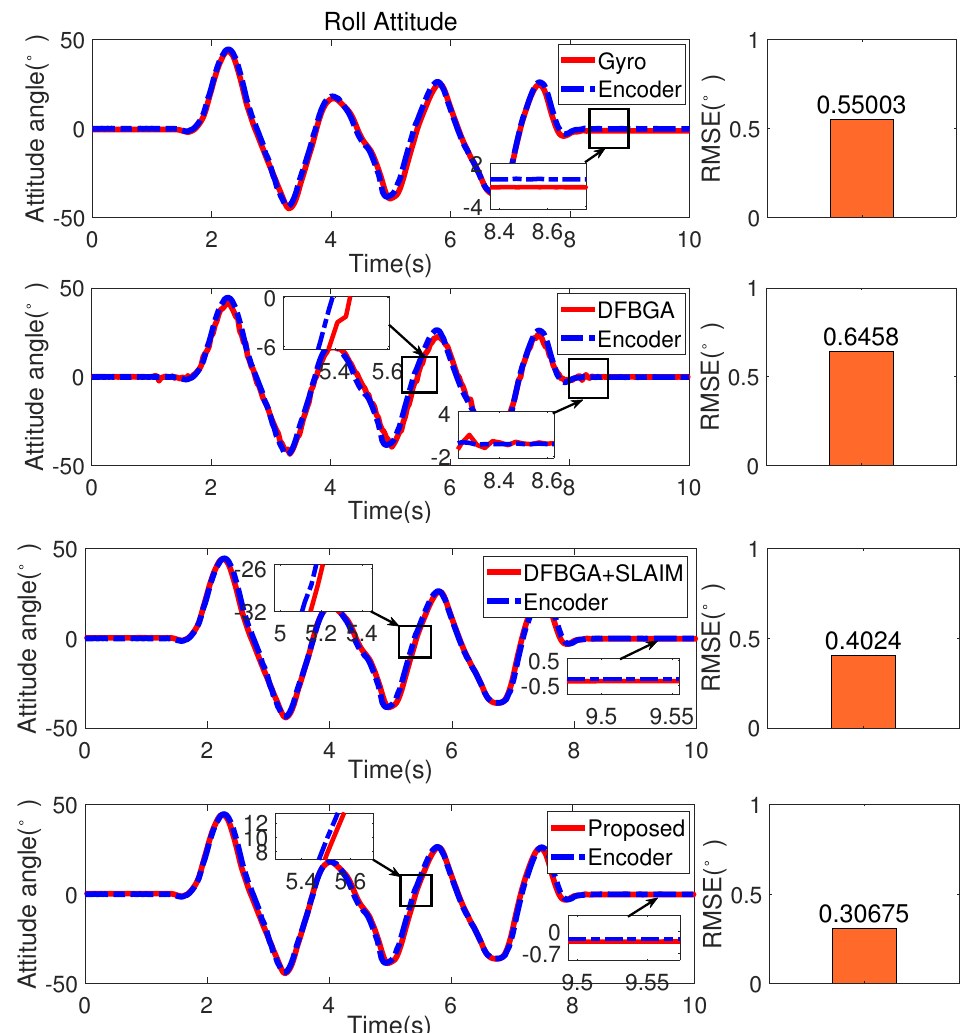
Figure 12. Roll angular attitude comparison. The first subfigure is the attitude calculated by gyro, the second subfigure is the attitude processed by DFBGA, the third subfigure is the attitude processed by DFBGA and SLAIM, the fourth subfigure is the attitude processed by proposed method.